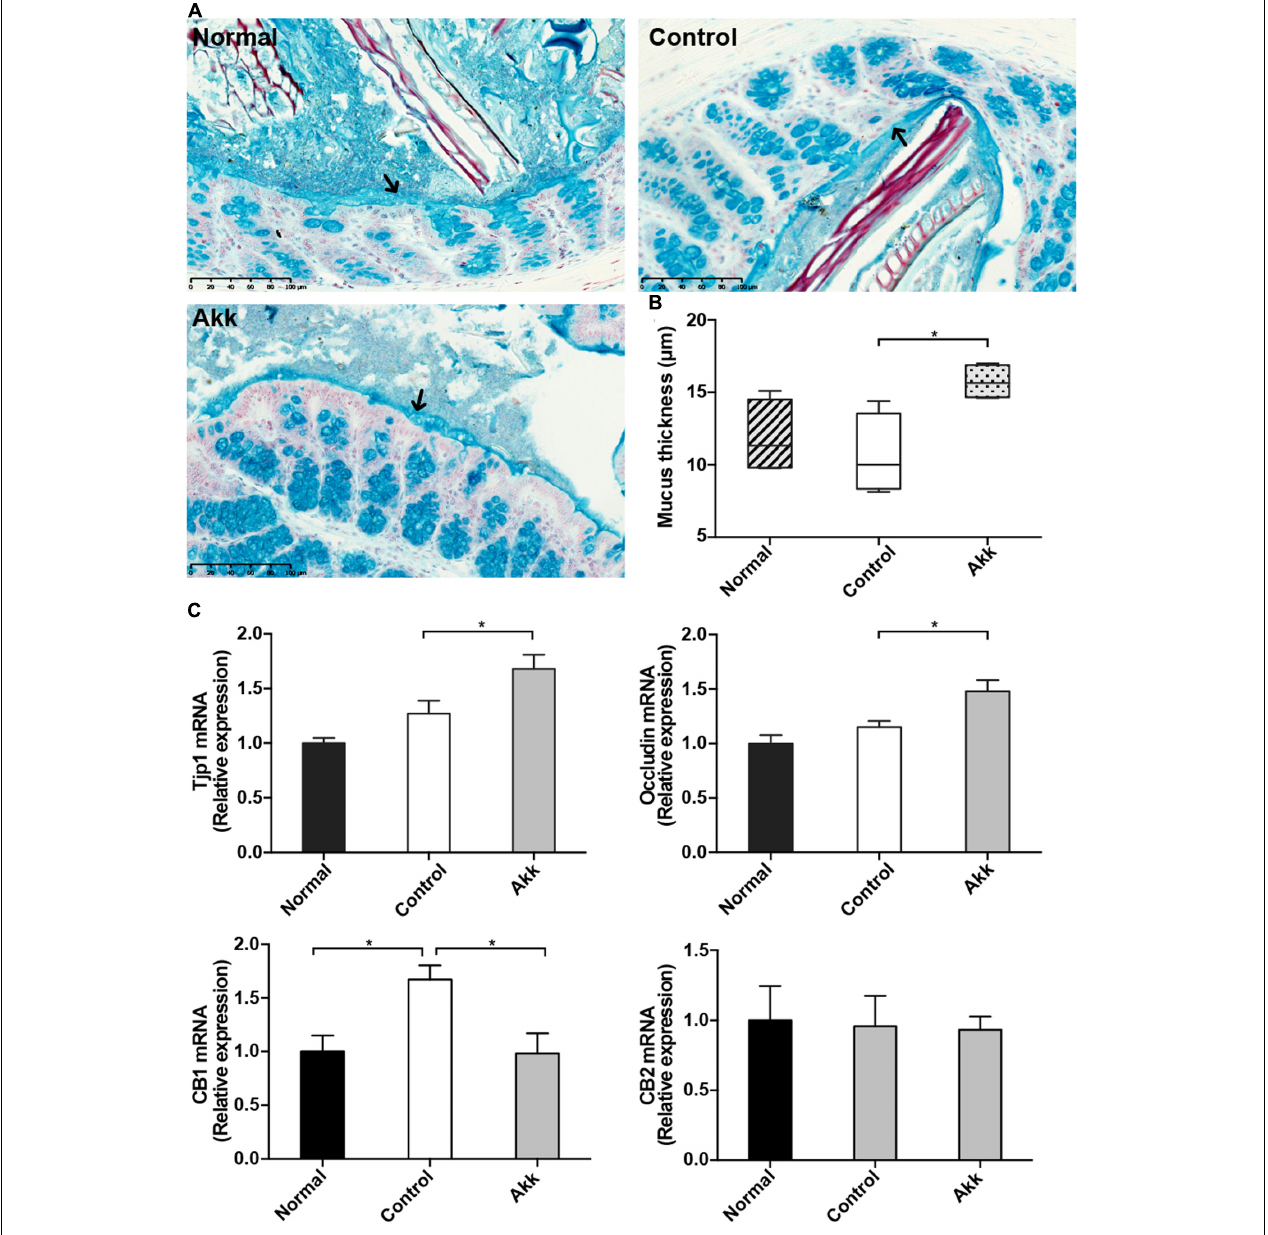
FIGURE 4 | Akkermansia muciniphila reinforced gut barrier function. (A) Representative Alcian blue images of the inner mucus layer. Scale bar, 100 µ m. (B) Thickness measurement of the inner mucus layer by Alcian blue staining. Data are expressed as Min to Max. (C) mRNA expression of Tjp1 , Occludin , CB1, and CB2 in the ileum. Data are shown as the mean ± SEM. ∗ P < 0.05 by post hoc ANOVA one-way statistical